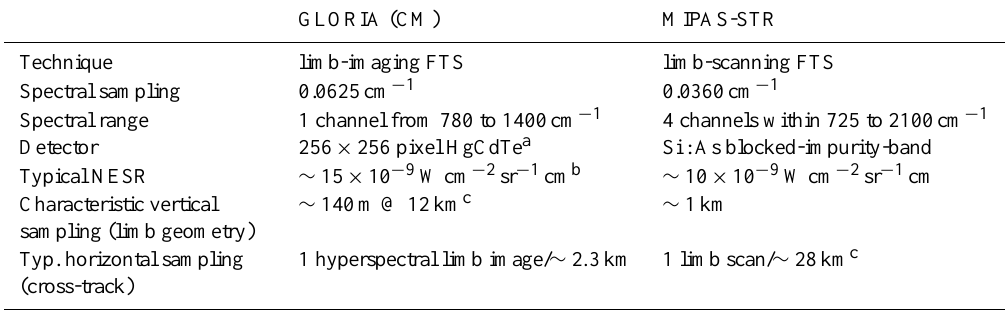
Table 1. Comparison of instrumental and measurement characteristics between GLORIA and MIPAS-STR. Data for GLORIA correspond to chemistry mode observations in ESSenCe configuration (CM: chemistry